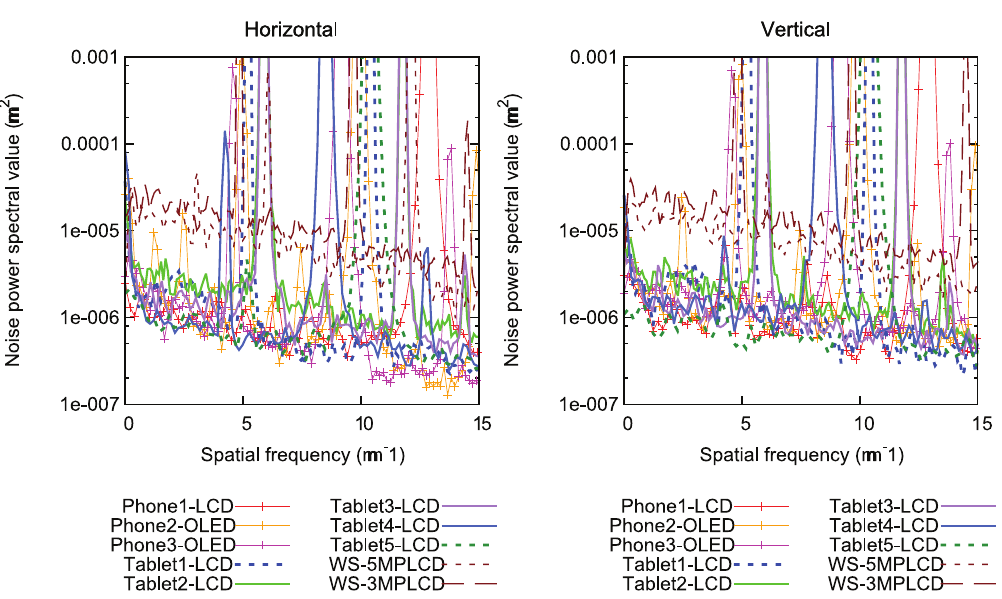
Figure 7. One-dimensional noise power spectra for the devices tested in this study.